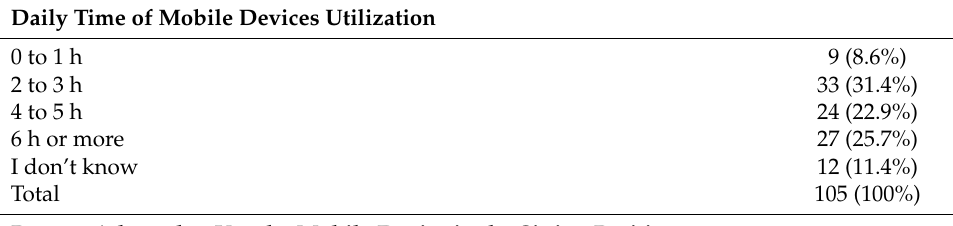
Table 2. Sample characteristics related to habits of mobile device use.